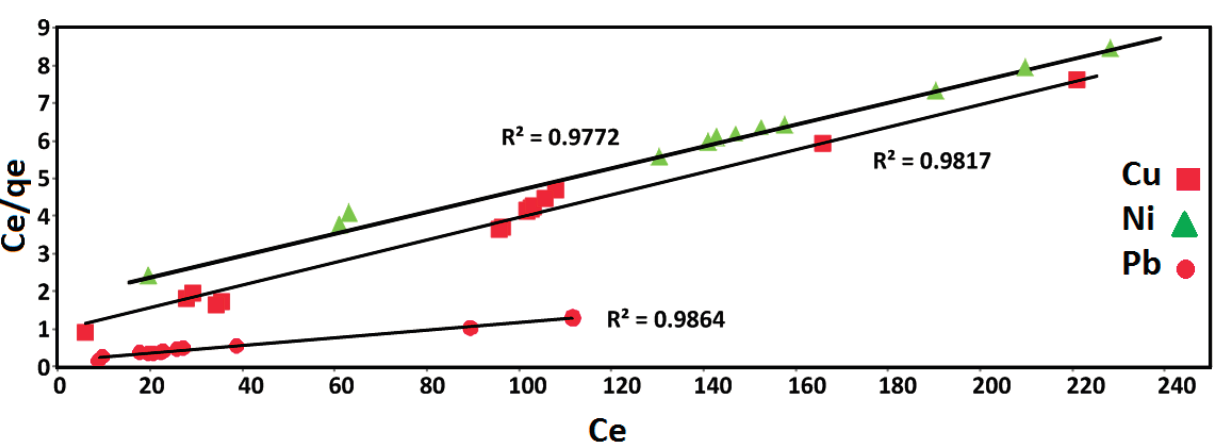
O /talc nanocomposite for Cu(II), Ni(II) and 3 4